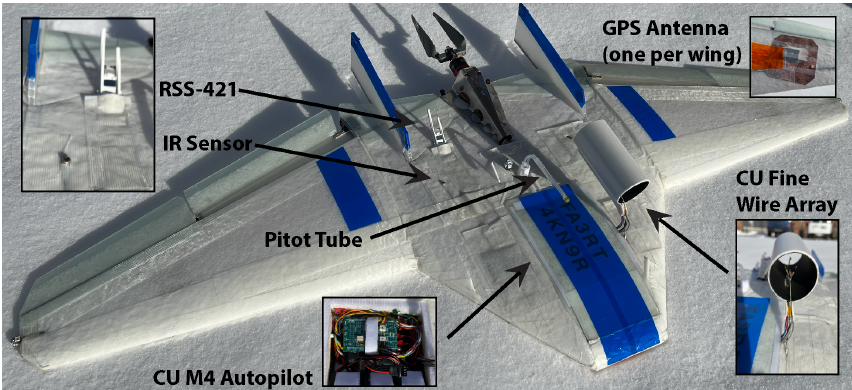
Figure 1. The DH2 sUAS. Detailed images show close ups of individual sensing systems and point out where these are